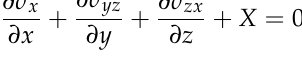
Figure 4. Distribution of stresses acting on the tested sample with an elemental volume [25].